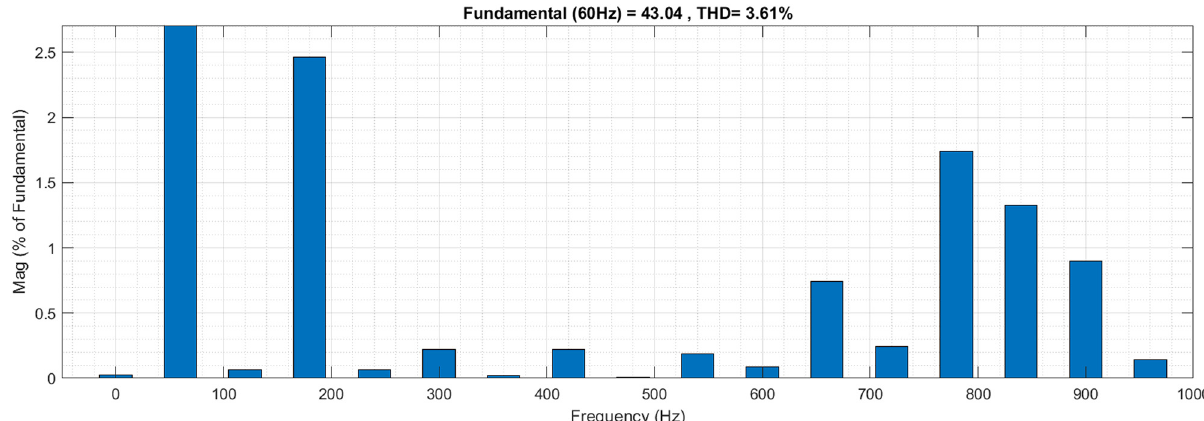
Figure 11: e abc THD. Scenario 2 ( proposed method ) – connection to an unbalanced power